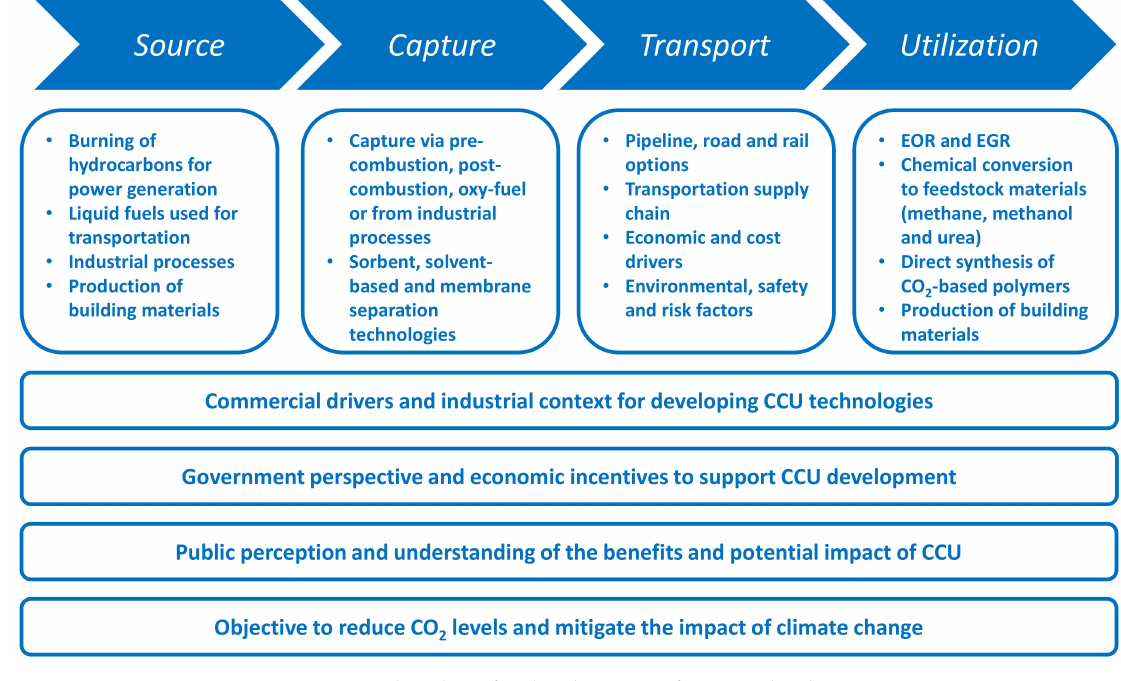
Figure 11. Value chain for development of CCU